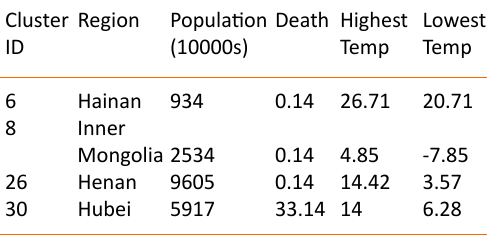
Table 4. K-means Cluster results on COVID-19 for death Vs